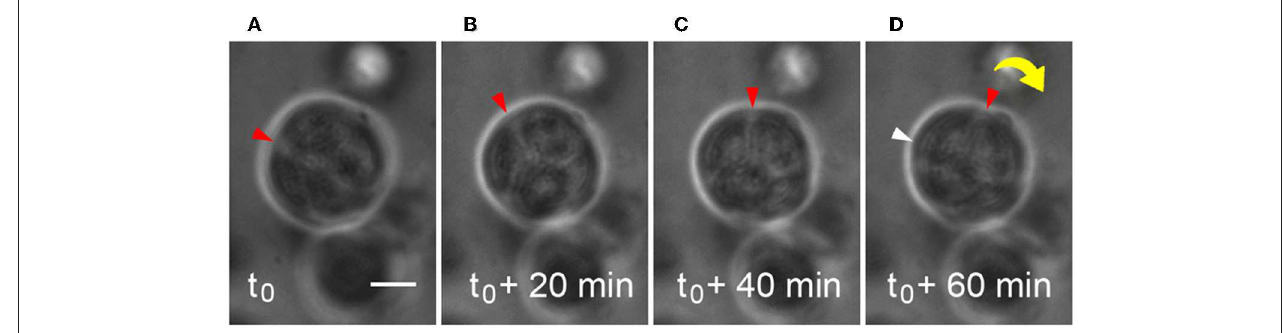
FIGURE 3 | Microstructure dynamics during rotation in HA-based hydrogel. Movement of a 30 µ m microstructure was measured and found to rotate ∼ 92 ◦ /h during basement membrane deposition. Still frames are extracted from time-lapse movies of microstructure motility at 20min intervals (A–D) . Scale bar = 10 µ m.